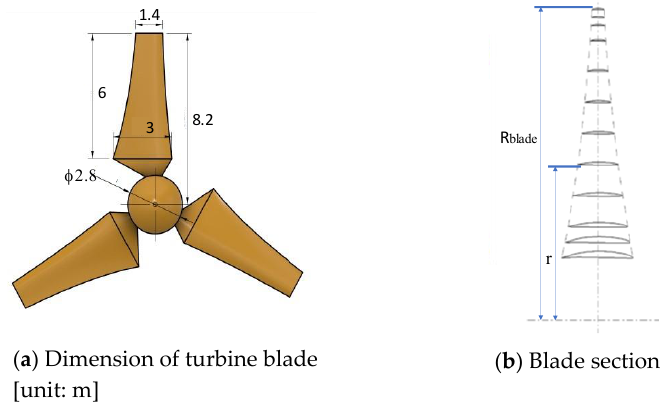
Figure 7. Configuration of turbine blade.